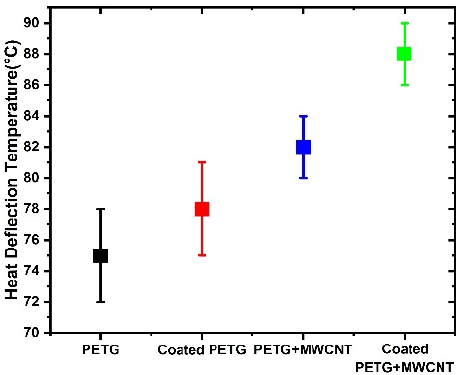
Figure 12. Heat deflection temperature for various PETG specimens.